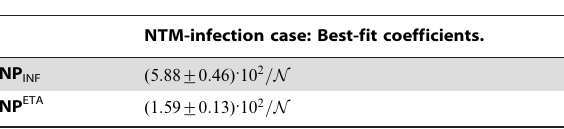
NTM-infection case: Best-fit